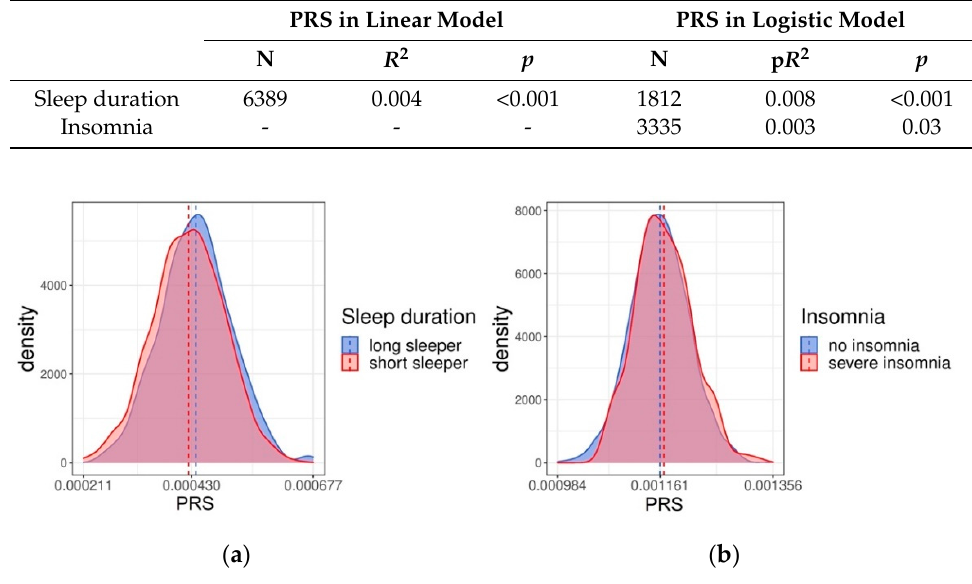
Figure 3. The distribution of polygenic risk scores (PRSs) for self-reported ( a ) sleep duration and ( b ) insomnia in Health 2000/2011 participants. The dashed lines mark the mean values for each group.